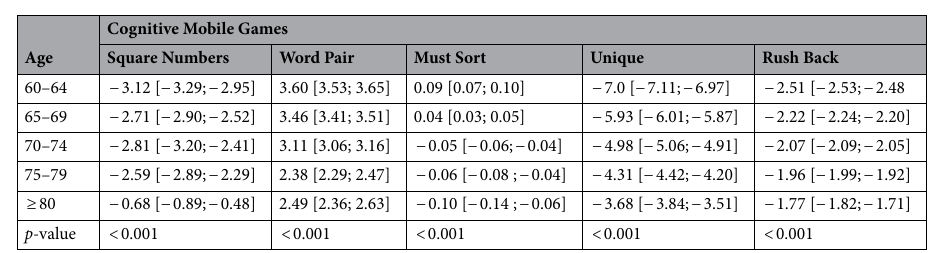
Table 4. Results of the mixed model, β coefficient [95% CI] representing the change of processing speed per session, results are expressed in ms. Models are adjusted for the difficulty levels and the total duration of the training (Supplementary Table